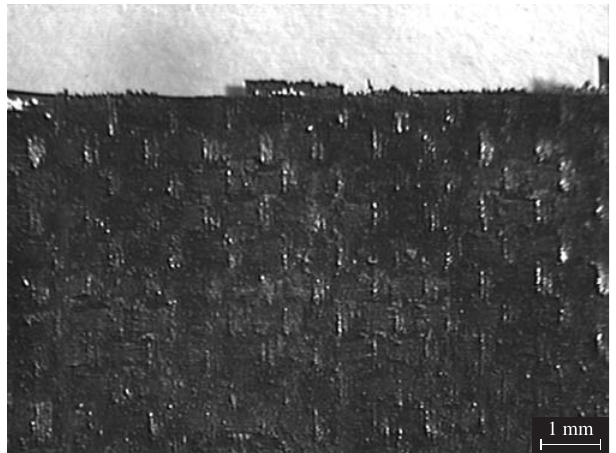
Figure 9. F584/PW specimen after tensile test, (10x).